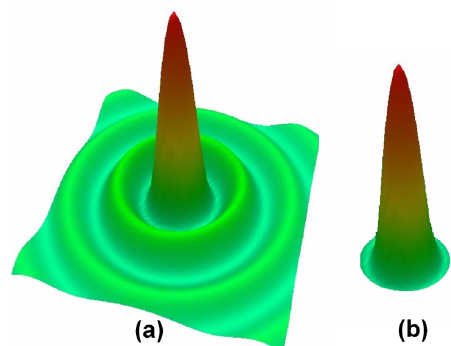
Figure 2. Intensity profiles of ( a ) a Bessel and ( b ) a needle beam schematically represented for an arbitrary plane perpendicular to the propagation axis (color-coded, red = maximum intensity, green = minimum intensity). Needle beams correspond to Bessel beams which are truncated exactly at the first zero (self-apodized